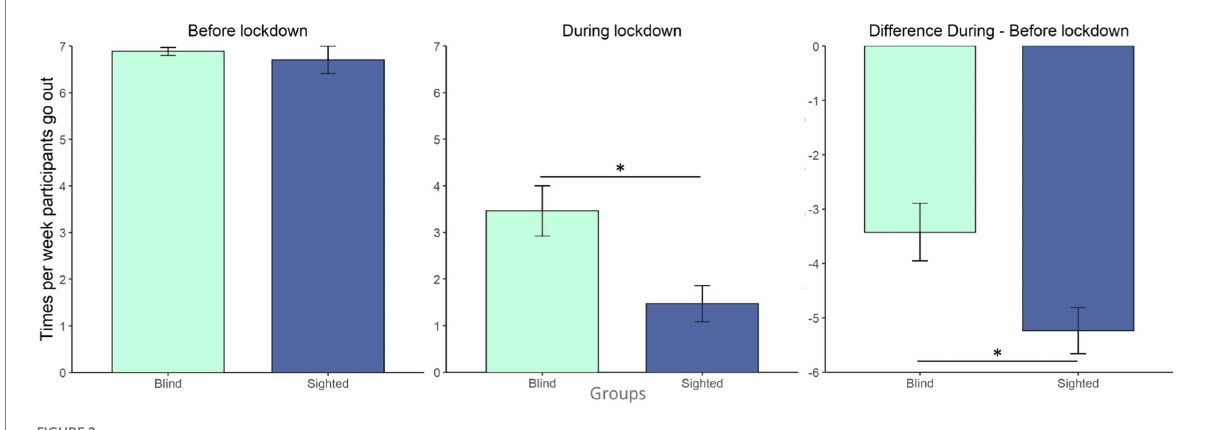
FIGURE 2 Number of times per week participants go out: bar plots show the number of times per week participants went out from home divided per group (in light blue blind group; in dark blue sighted controls group) before the lockdown (left panel), during the lockdown (central panel) and the difference between during and before the lockdown (right panel, negative values mean fewer outings during the lockdown). Error bars show the standard error of the mean. * : value of p